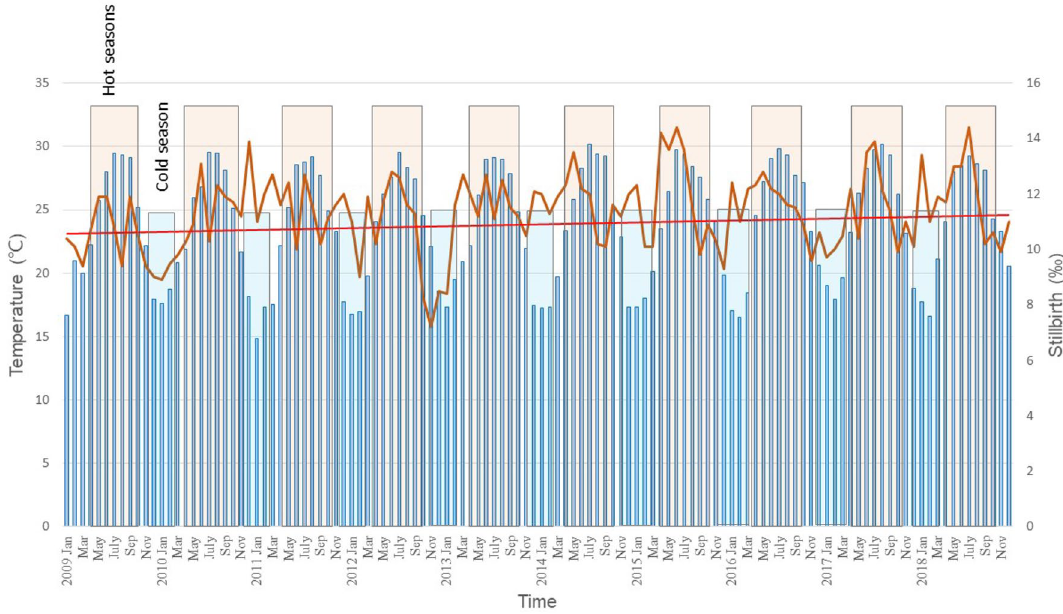
Figure 1. Monthly average temperatures and stillbirth rates in Taiwan from January 2009 to December 2018. The monthly average temperatures (blue bar charts) show a seasonal pattern. There was an increased stillbirth rate (orange line) in the hot seasons. The red line is the trendline of stillbirths, showing an increased risk of stillbirth in Taiwan over